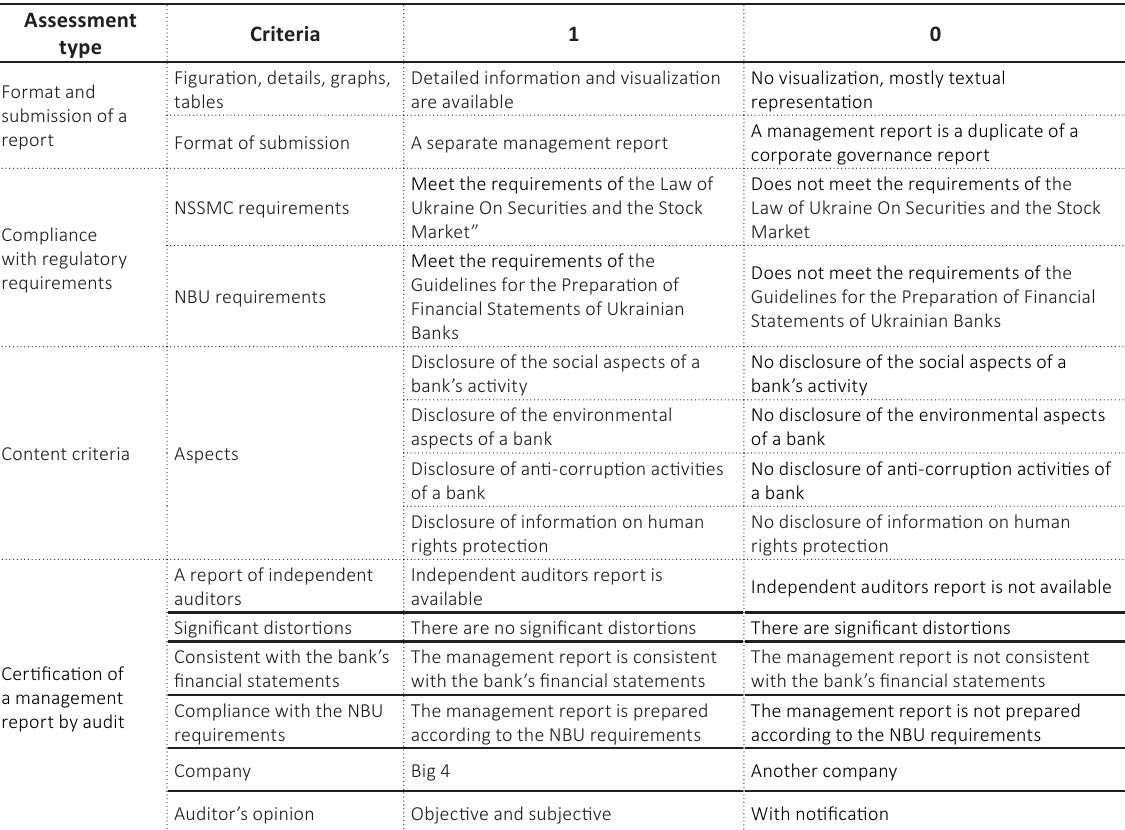
Table 2. A scoring criteria system for assessing the quality and compliance of management reports of Ukrainian